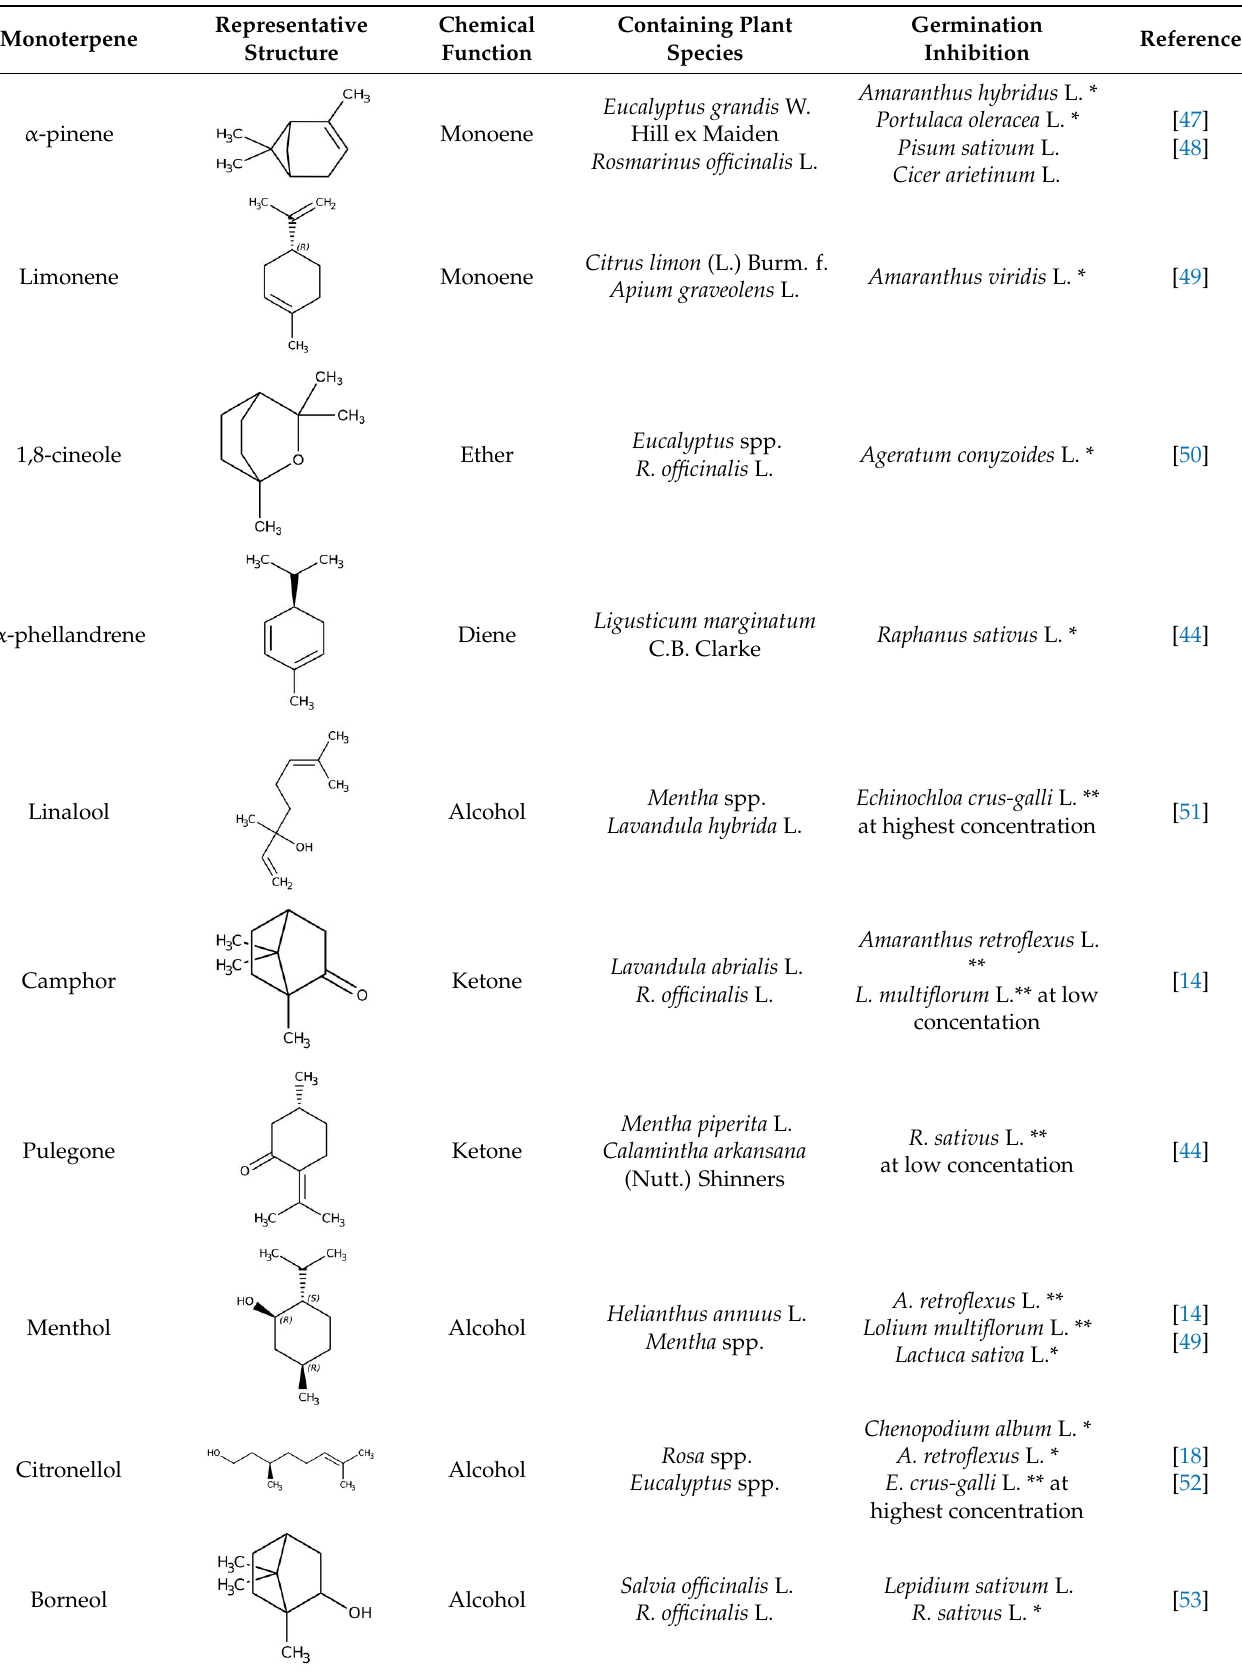
Table 3. Examples of monoterpenes and their phytotoxic effect.